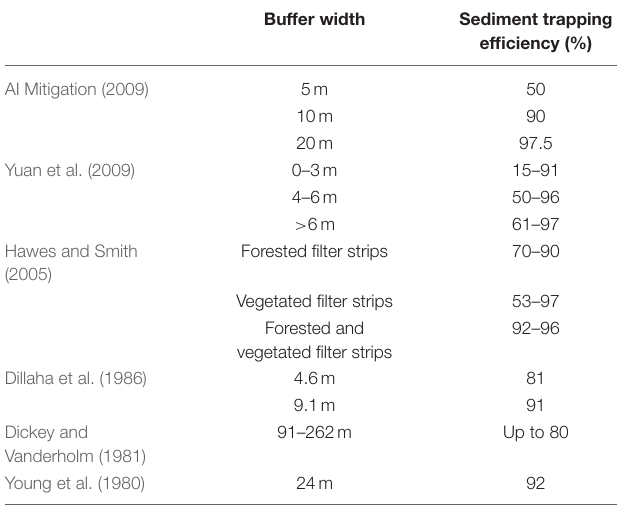
trapping efficiency. Buffer